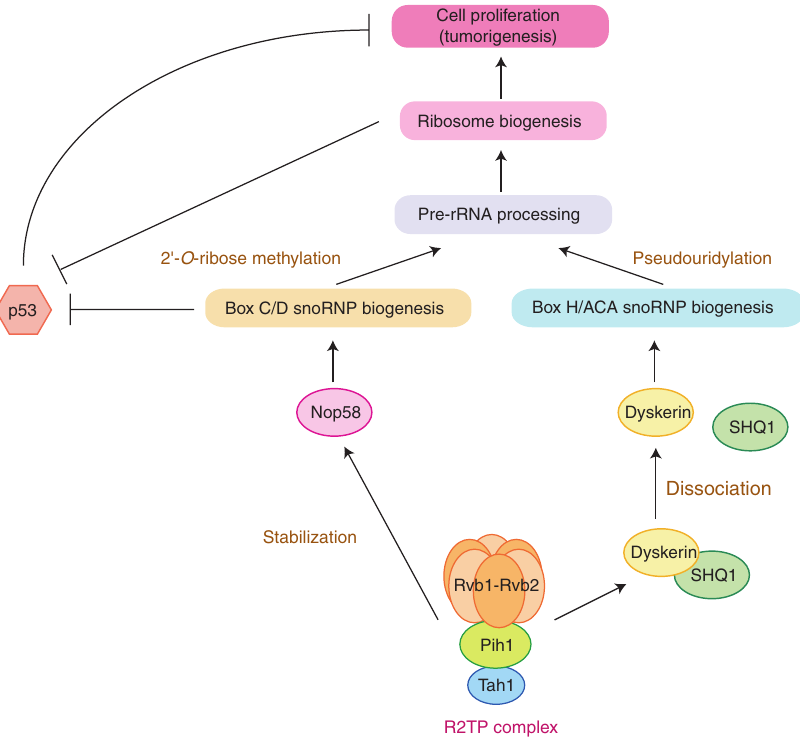
Figure 3 Involvement of R2TP in cell proliferation/tumorigenesis through snoRNP biogenesis. R2TP regulates both box C/D and box H/ACA snoRNP biogenesis, and subsequently controls pre-rRNA processing, ribosome biogenesis, and cell proliferation. Elevated snoRNP biogenesis inactivates p53 activity and triggers tumorigenesis, whereas inhibition of snoRNP bio- genesis activates p53 and inhibits the cell